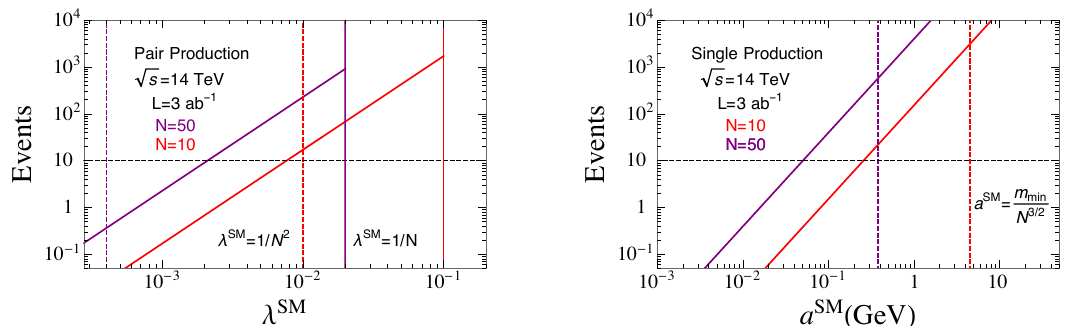
Figure 7. Total number of events from pair production (left) and from single production (right) p in 3 ab (cid:0) 1 of s = 14 TeV LHC data. For pair production the upper end of the lines corresponds to (cid:21) SM = 1 =N and the dotted line indicates where (cid:21) SM = 1 =N 2 . For single production the dotted line indicates where a SM = m =N 3 = 2 where m is the lightest scalar mass. min min